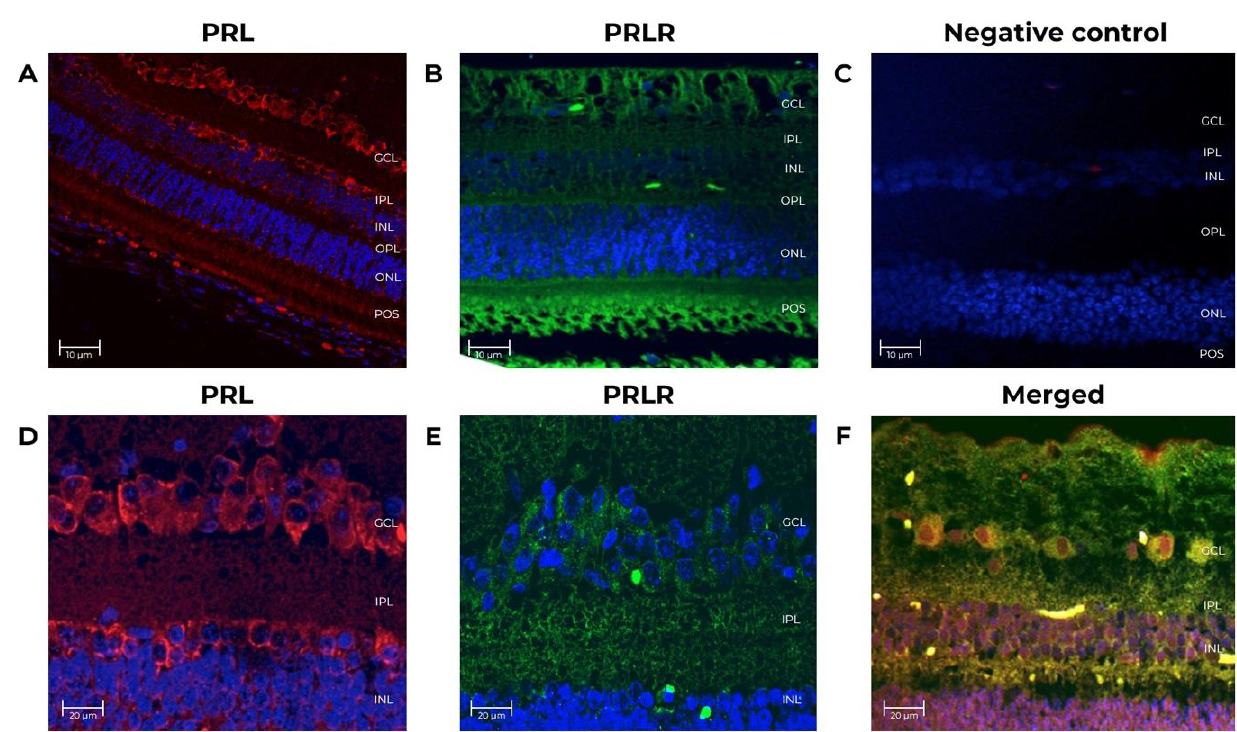
Figure 2. Prolactin and prolactin receptor immunoreactivity in the neural retina from adult female baboons. The tissues correspond to adult baboon ID 14871. Confocal images of immuno-stained retina sections identified cells expressing PRL and PRLR. ( A ) PRL expression (red, 1st Ab: mouse anti-human PRL 1:100; goat anti-mouse IgG Cy5 1:400). Nuclei (blue) were counterstained with DAPI. ( B ) PRLR expression (green, 1st Ab: mouse anti-human PRLR 1:250; goat anti-mouse IgG-FITC 1:250), nuclei (blue). ( C ) Negative control for IgG Cy3 antibody has no primary antibody (mouse anti-human PRL 1:100). ( D ) PRL retina sections (5 μm -thick) at 25X magnification, scale-bar 20 μm . ( E ) PRLR sections at 25X magnification, scale- bar 20 μm. ( F ) Double-stained sections